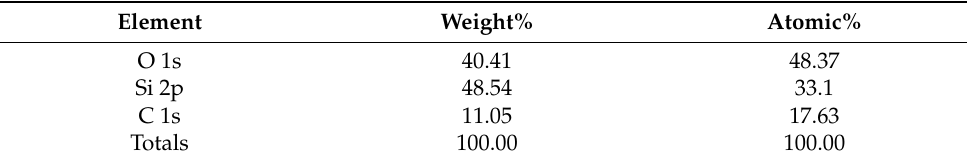
Figure 3. Structure and elemental characterization of siloxene nanosheets. ( a ) XRD patterns of CaSi 2 powders, purified CaSi 2 powders, and siloxene nanosheets; ( b ) Raman spectra of CaSi 2 powders and siloxene nanosheets; ( c ) FT-IR spectrum; ( d ) X-ray photoelectron spectra for full range scan; ( e ) fitting curves of the Si 2p core level; ( f ) fitting curves of the O 1s core level of siloxene nanosheets. Table 2. XPS full spectrum element of siloxene nanosheets.